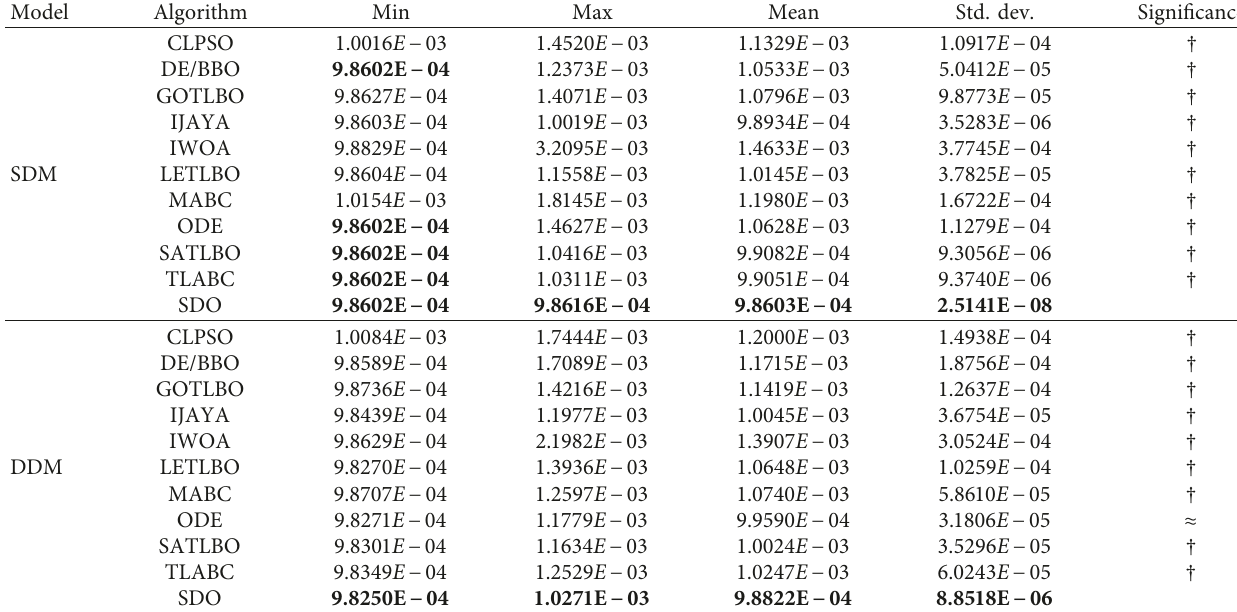
Table 3: Experimental results on the RTC France solar